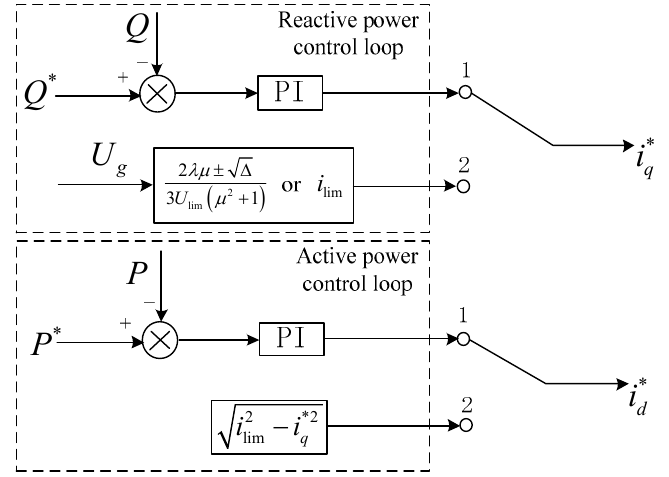
Figure 5. Control block diagram of the VSC inverter.